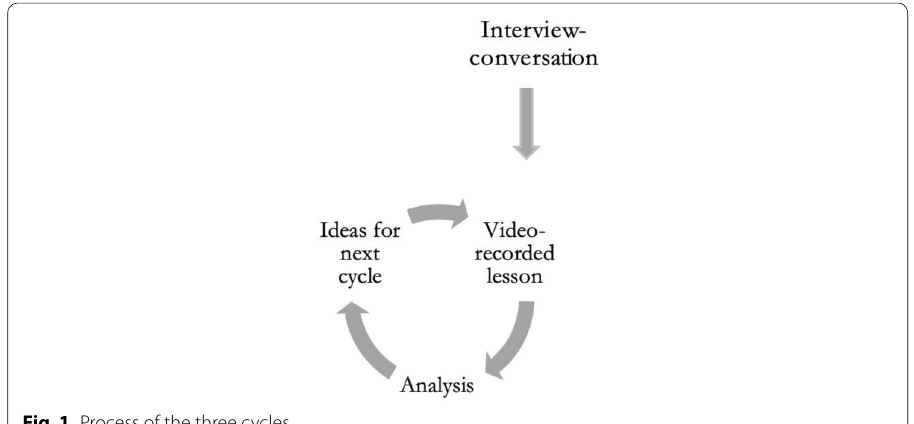
Fig. 1 Process of the three